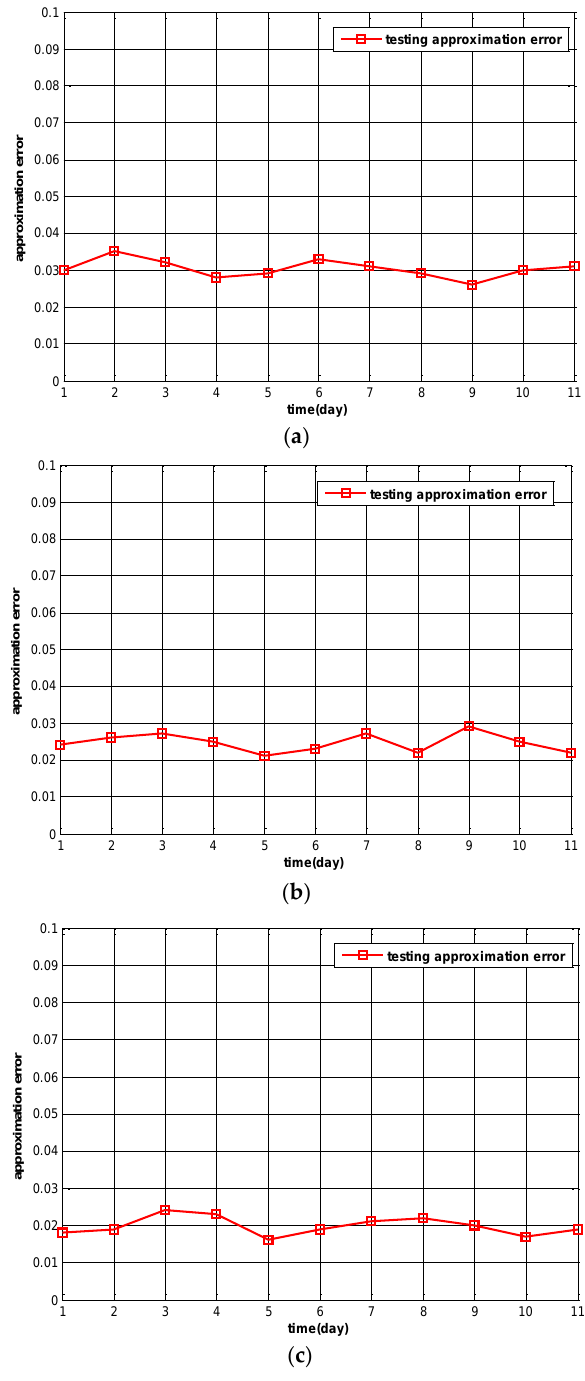
Figure 6. Testing approximation errors of IPSA. ( a ) 10 active participants (training loss threshold = 0.025); ( b ) 15 active participants (training loss threshold = 0.015); ( c ) 20 active participants (testing loss threshold = 0.005).